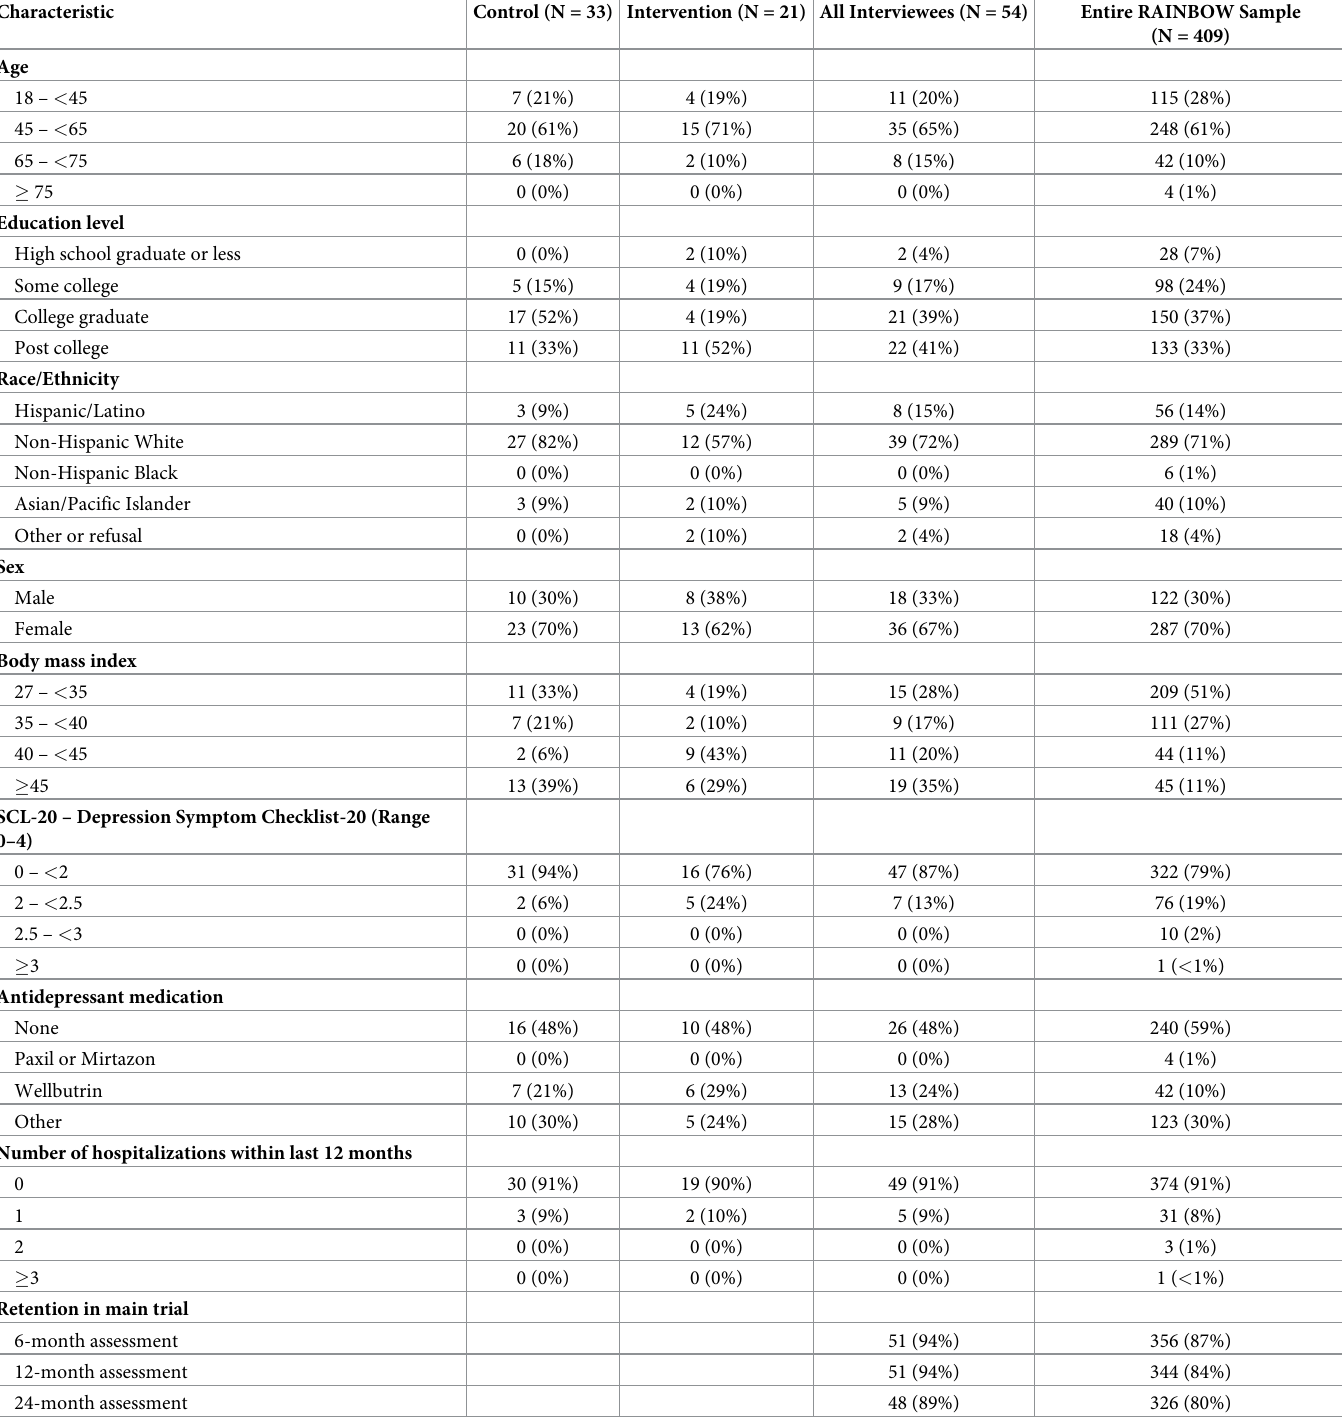
Table 4. Baseline demographic and health characteristics of interview and main trial